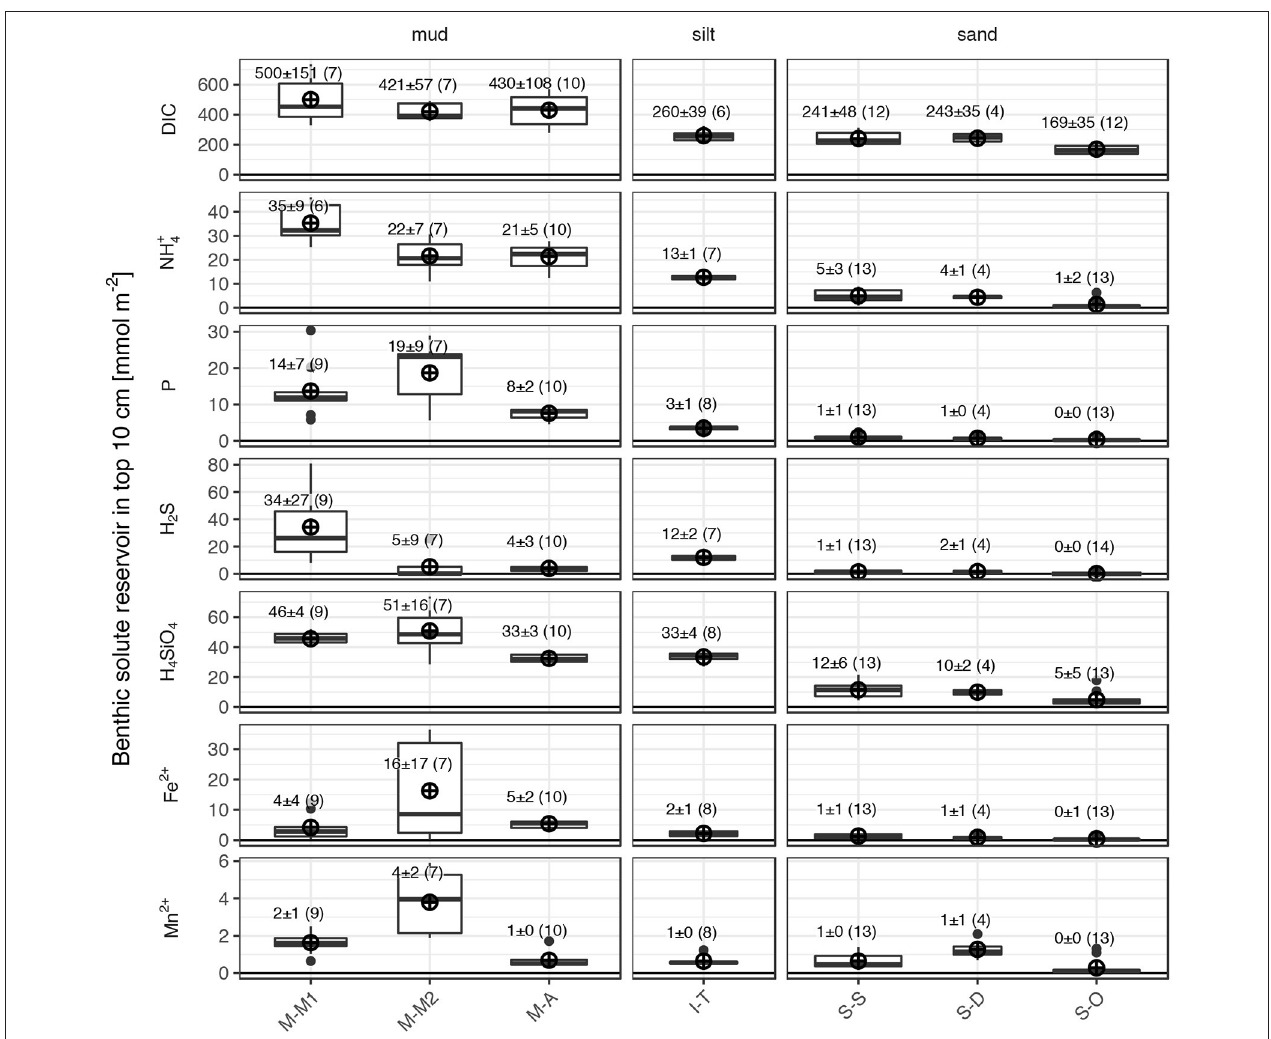
FIGURE 7 | Benthic solute reservoirs of the top 10 cm of the southern Baltic Sea sediments calculated from the pore water profiles shown in Figure 6 and visualized by boxplots. Each boxplot summarizes the data from multiple pore water profiles for each site and parameter. The lower and upper hinges of the boxes correspond to the 25 and 75th percentiles, the line within the boxes represents the median. The whiskers extend from the hinges to the largest and smallest value inside the 1.5-fold inter-quartile range. Labeled ⊕ mark the arithmetic mean reservoir size of each subset ( ± one standard deviation, number of cores in